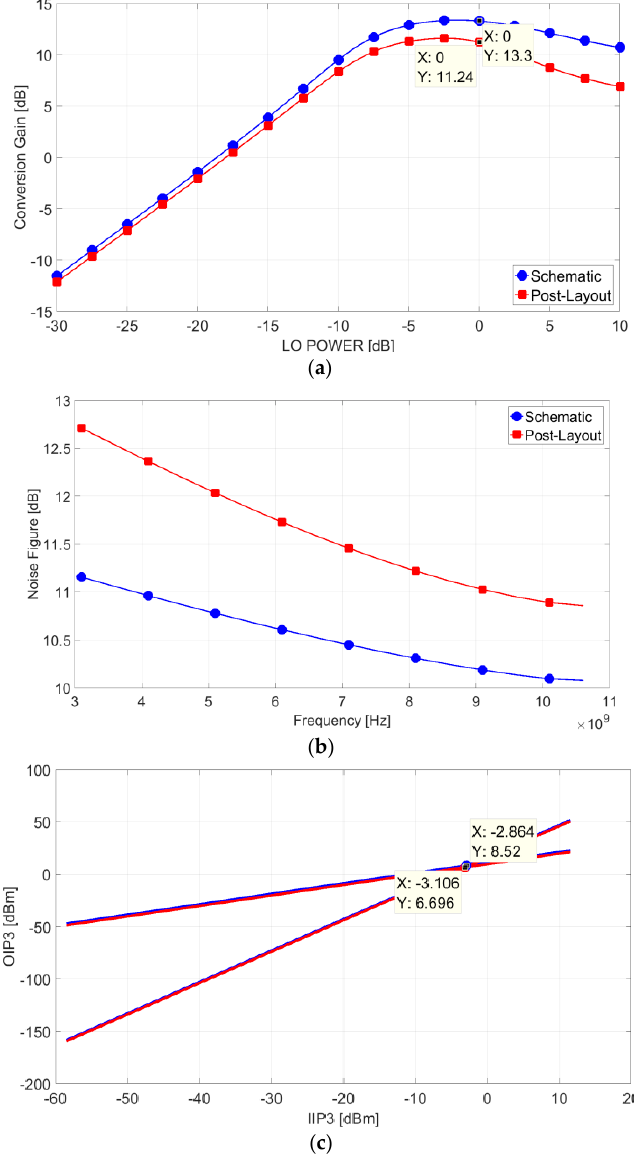
Figure 8. Post-Layout Simulation ( a ) Mixer Conversion Gain vs. LO power ( b ) Mixer NF vs frequency ( c ) Mixer OIP3.